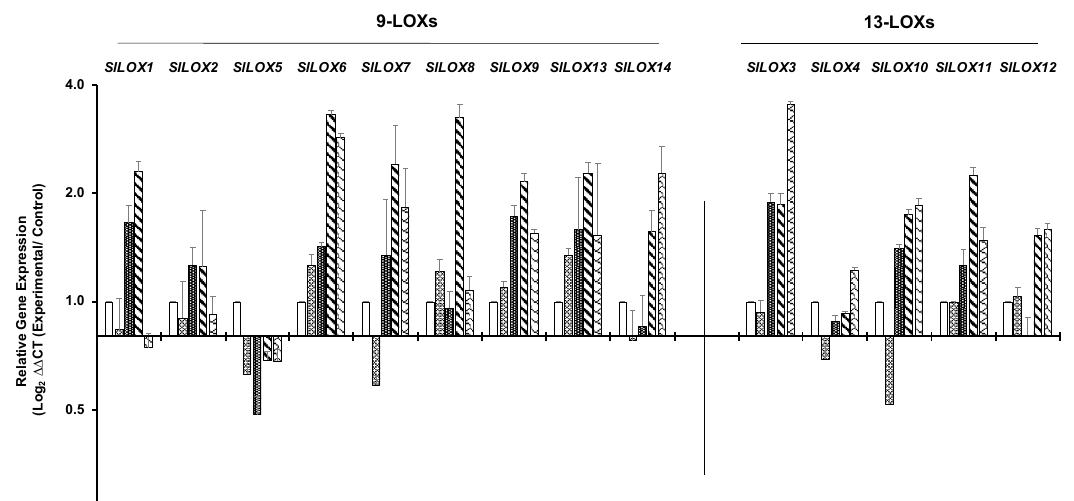
Figure 5. qRT-PCR analysis of tomato ( S. lycopersicum cv. Ailsa Craig) LOX gene family members in response to drought stress. Graphical representation of 9- LOX genes and 13-LOX genes in response to drought (water withheld for 168 h). A non-treated control (0 h) was used as a calibrator in qRT-PCR data calculation and for defining statistical significance of treatment data points at levels * p < 0.05, ** p < 0.01 and *** p < 0.001. Details are given in Figure S3. A minimum of three biological replicates, where each biological replicate was comprised of two technical replicates, were used for each time point. SlTIP41 and SlUBI3 housekeeping genes were used to normalize the expression of target